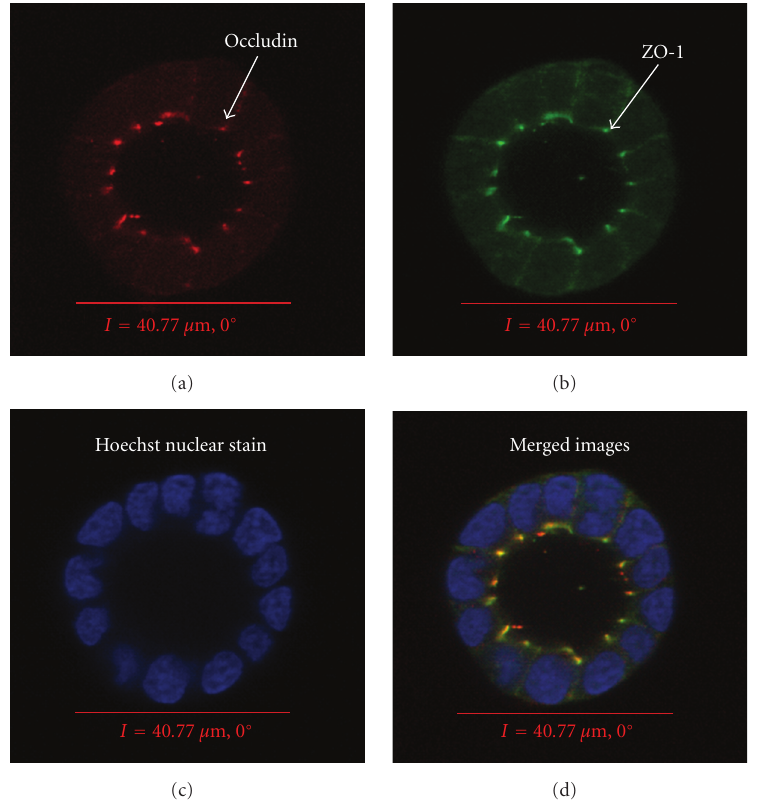
Figure 2: Three-dimensional Par-C10 acinar-like spheres express TJ as markers of acinar di ff erentiation. Protein expression was detected using immunofluorescence microscopy with goat antimouse occludin (a and d: red), rabbit anti-ZO-1 (b and d: green), followed by Hoechst nuclear stain (c and d: blue). Images were obtained and analyzed using a Carl Zeiss 510 confocal microscope. Sphere diameter taken at the widest point of the xy plane (I) is shown in μ m. This model has been published